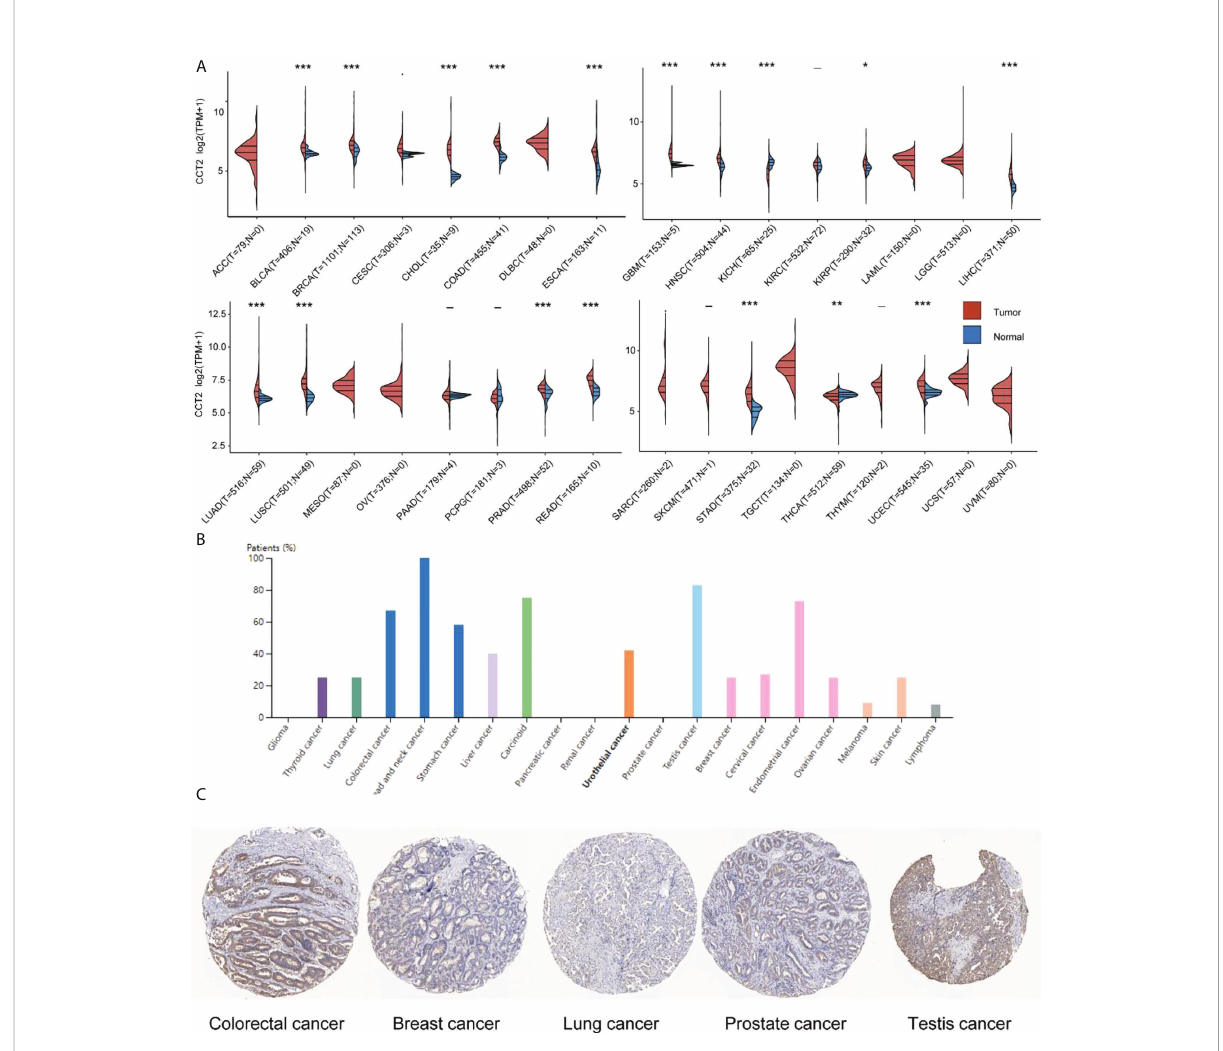
FIGURE 1 CCT2 expression in human pan-cancer. (A) Differential expression of CCT2 mRNA in tumor and normal tissues in the TCGA cohort. (B) Twenty cancer types in which CCT2 protein pachytene was present. (C) Representative immunohistochemical staining for CCT2 in Human Protein Atlas. * p < 0.05, ** p < 0.01, *** p <